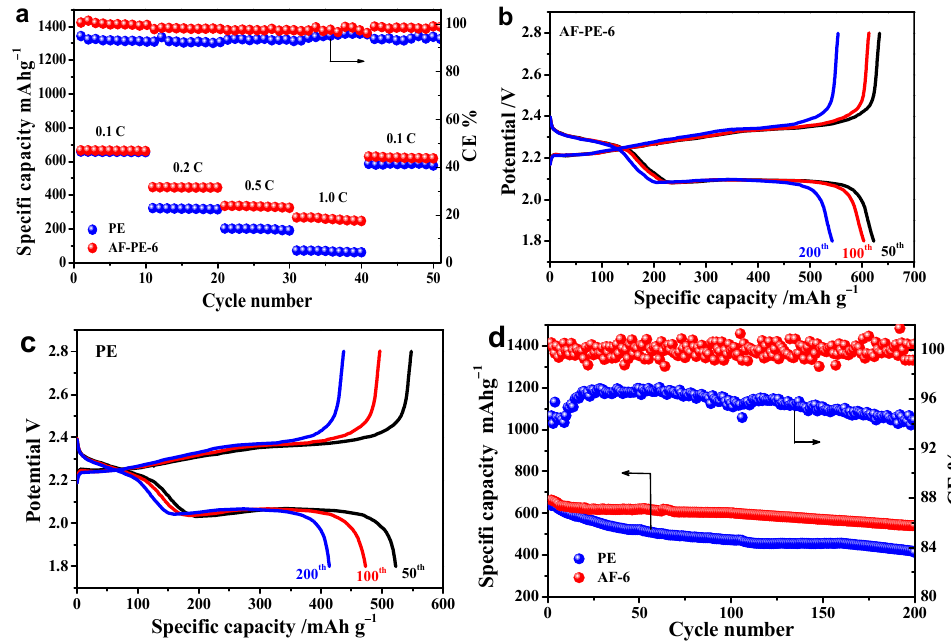
Figure 4. ( a ) The specific capacity and the related coulombic efficiency of PE and AF-PE-6 cells at various C rates with 10 cycles for each. The GCD curves of: ( b ) AF-PE-6 and ( c ) PE cells at the 50th, 100th and 200th cycles; ( d ) The cyclic performance of PE and AF-PE-6 cells and the related coulombic efficiency.